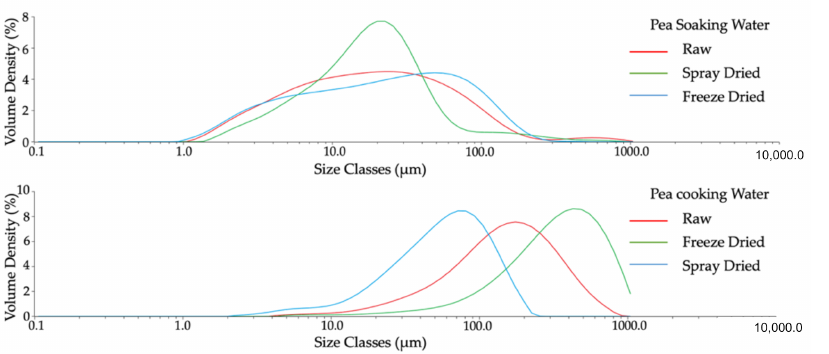
Figure 2. Particle size distribution of pea soaking water ( above ) and pea cooking water ( below ) in different physical states: raw, spray-dried and